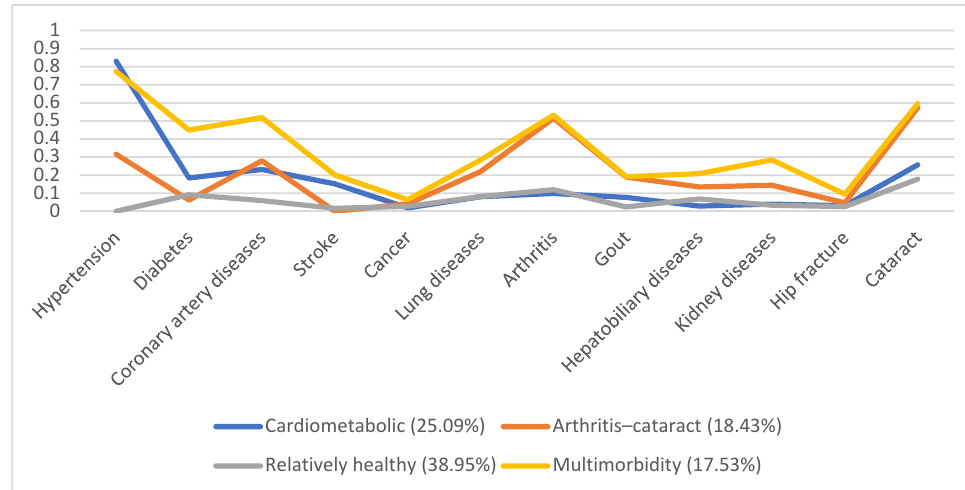
Figure 2. Multimorbidity patterns in 1999.